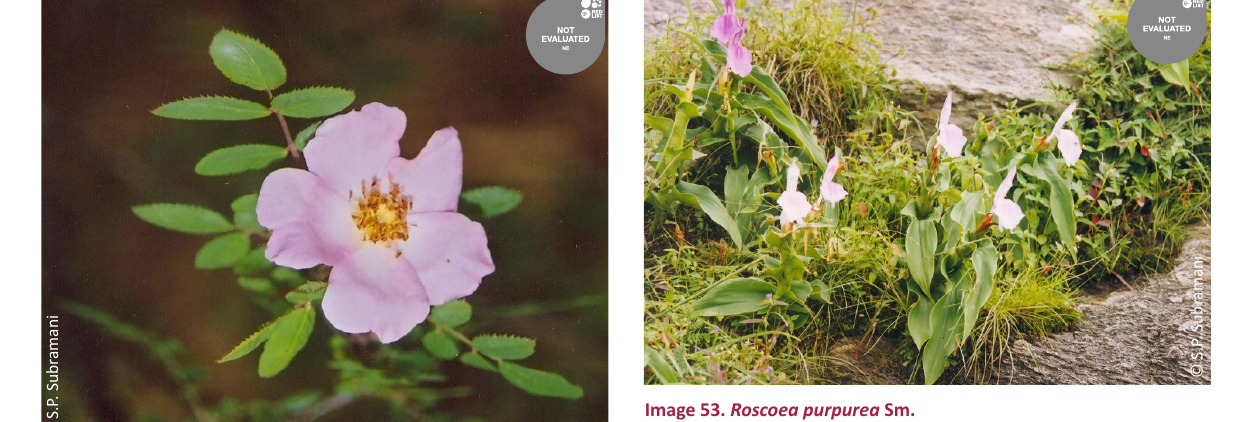
Image 53. Roscoea purpurea Sm.